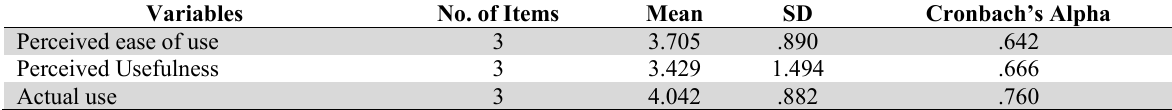
Mean scores and analysis of internal consistency